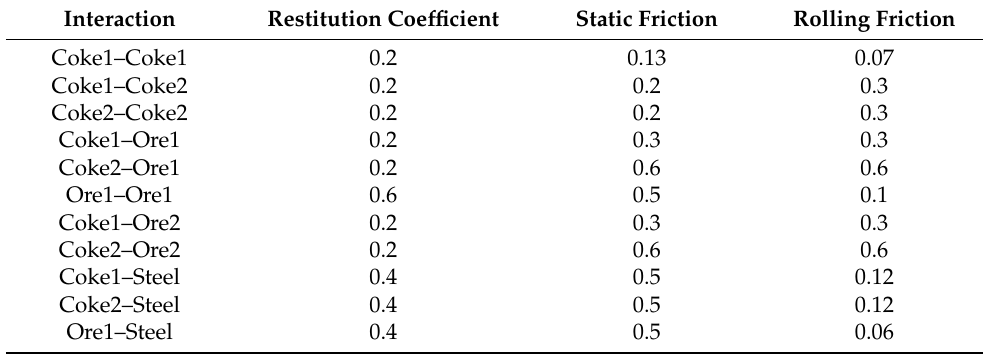
Table 7. Contact parameters between different